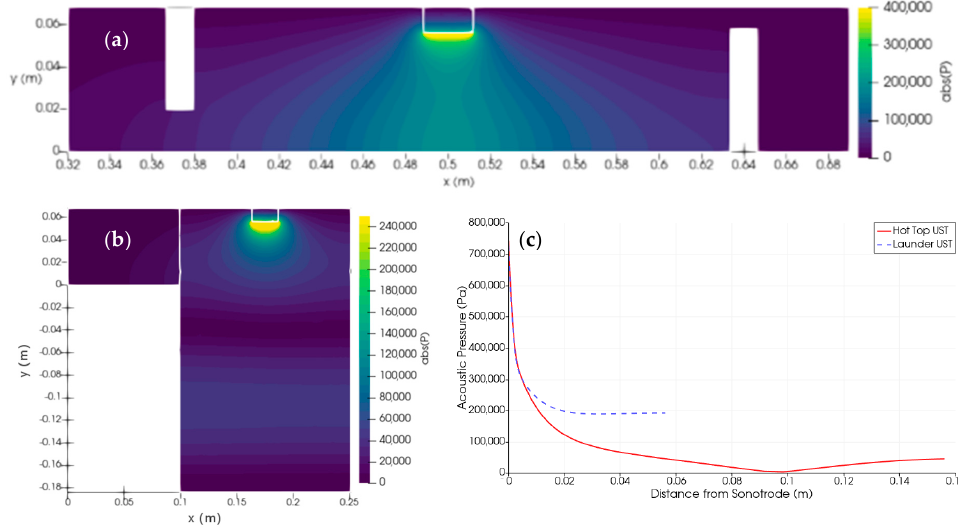
Figure 4. Acoustic pressure distribution in the launder ( a ) and the hot-top ( b ) a comparison of the pressure observed as a function of the vertical distance from the sonotrode tip is given in ( c ).